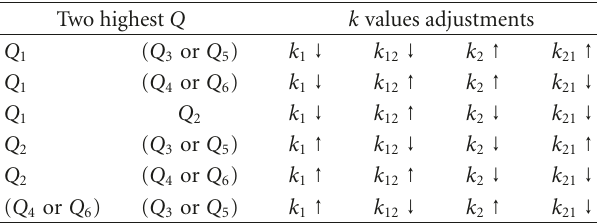
Table 1: Adjustment of the k parameters.